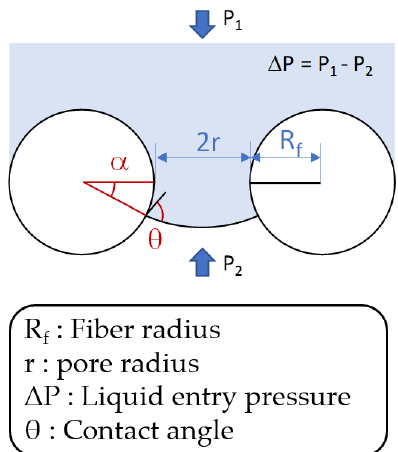
Figure 3. Interface in toroidal pore of hydrophobic membrane based on Purcell